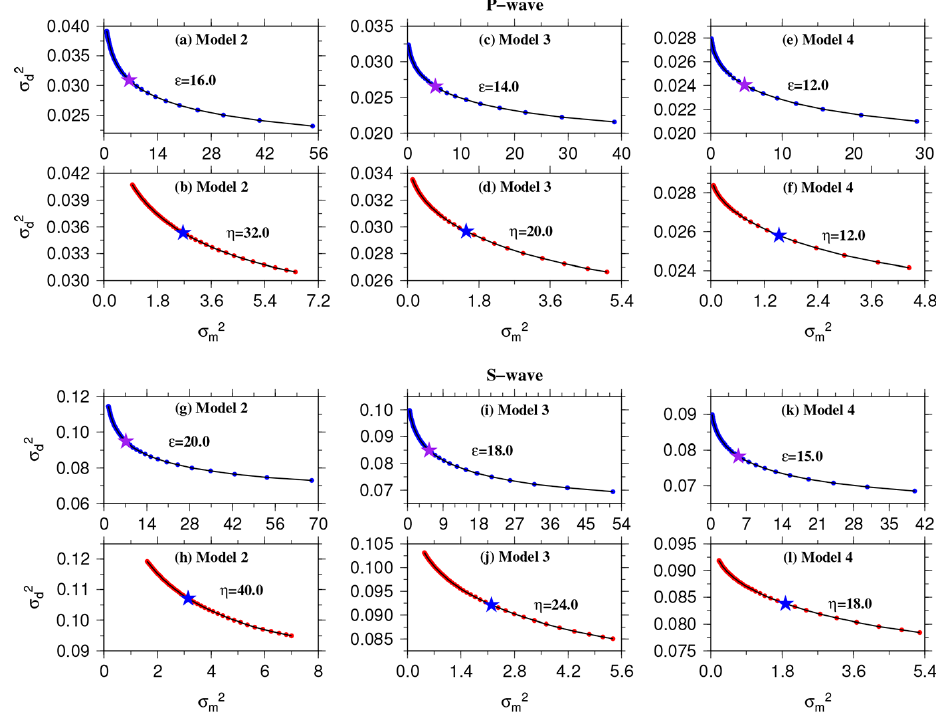
Figure 10. Trade-off analysis of data variance σ 2 and model variance σ 2 m for 35 damping values equally in [ 6 . 0 , 40 . 0 ] and 50 smoothing d values over [ 2 , 100 . 0 ] with an interval of 2.0 at each iteration to obtain P wave (a–f) and S wave (g–l) models m 2 − m 4 . By setting the smoothing parameter η = 0 . 0, the optimal damping parameter (cid:15) is first determined based on the L curve method as shown in (a) , (c) , (e) , (g) , (i) , and (k) at each iteration. The purple stars highlight the values of data variance σ 2 and model variance σ 2 m calculated with the optimal d damping parameters. The optimal smoothing parameter η is then determined with the corresponding optimal damping parameter also based on the L curve method in (b) , (d) , (f) , (h) , (j) , and (l) . The blue stars are at the crosses determined by the values of data variance σ 2 and d model variance σ 2 m calculated with the optimal damping and smoothing parameters. The value of the unitless model variance σ 2 m is at the scale of 10 − 4